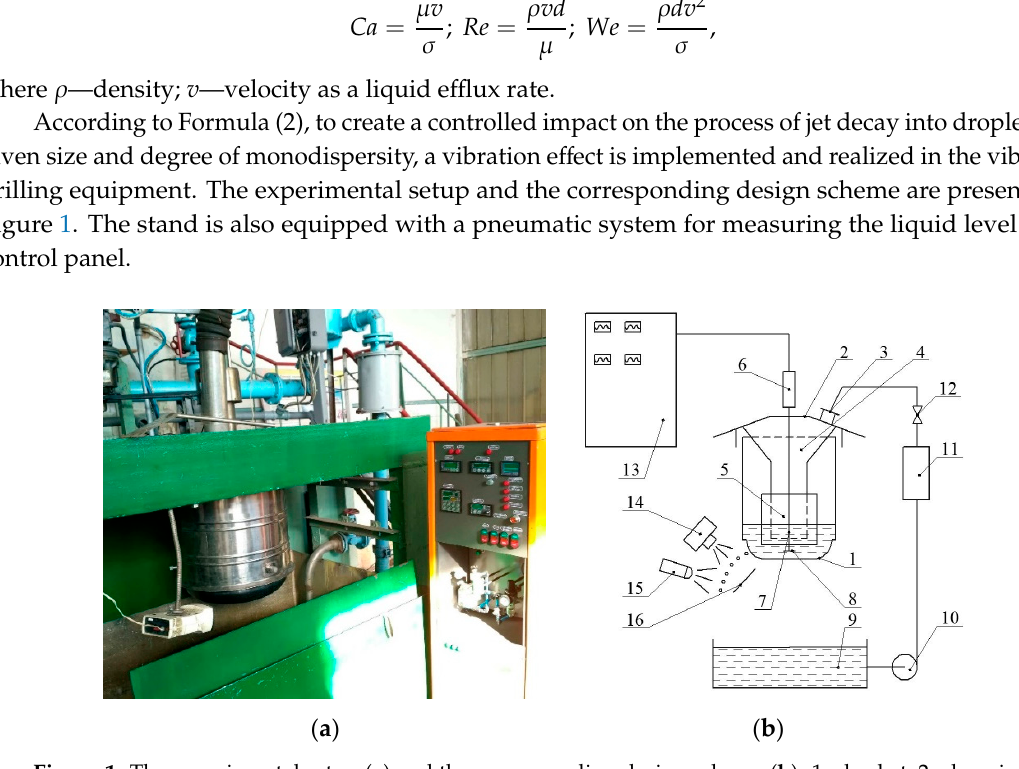
Figure 1. The experimental setup ( a ) and the corresponding design scheme ( b ): 1—basket;